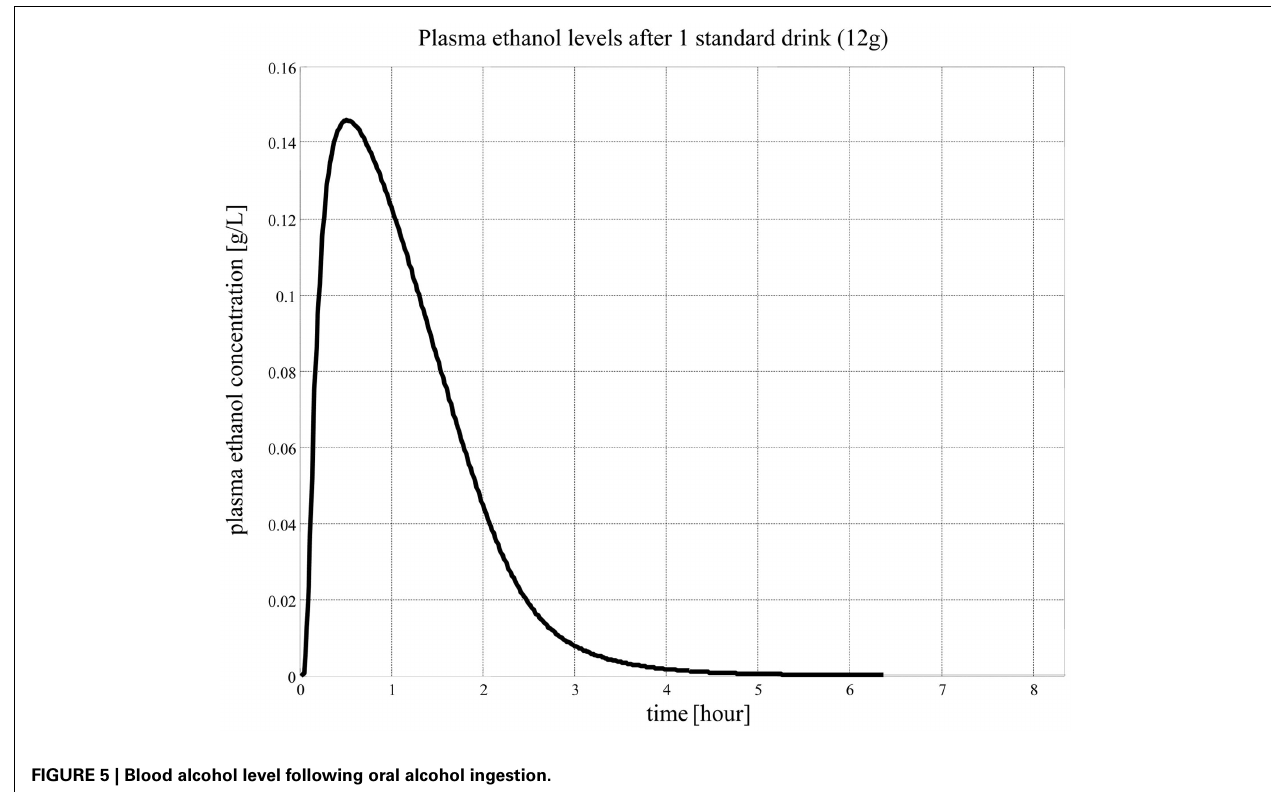
FIGURE 5 | Blood alcohol level following oral alcohol ingestion.